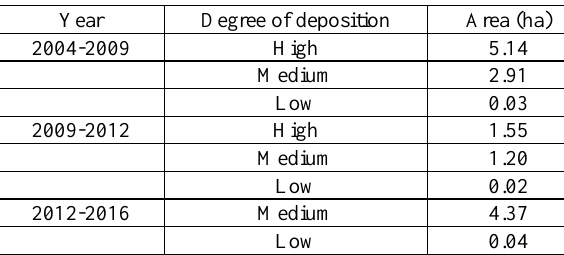
Table 4. Coastal deposition between 2002 and 2016